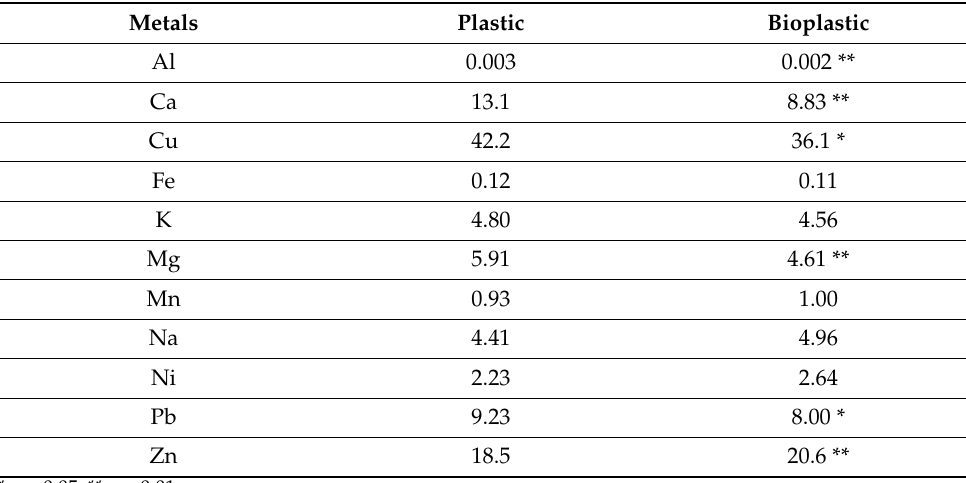
Table 3. Mean values of ratios (expressed as percentage) of elements available and total concentration measured after six months of exposure. Asterisks indicate statistically significant differences between soils covered by plastic and bioplastic, respectively ( t -test; p <